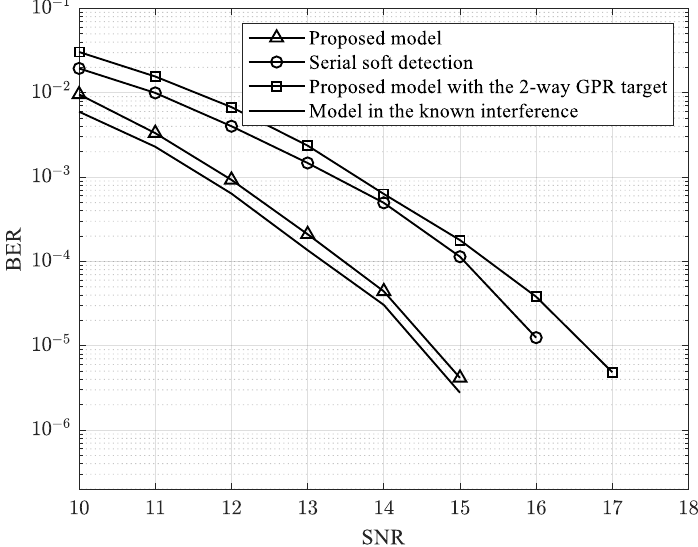
Figure 12. BER vs. SNR with 6% position fluctuation.